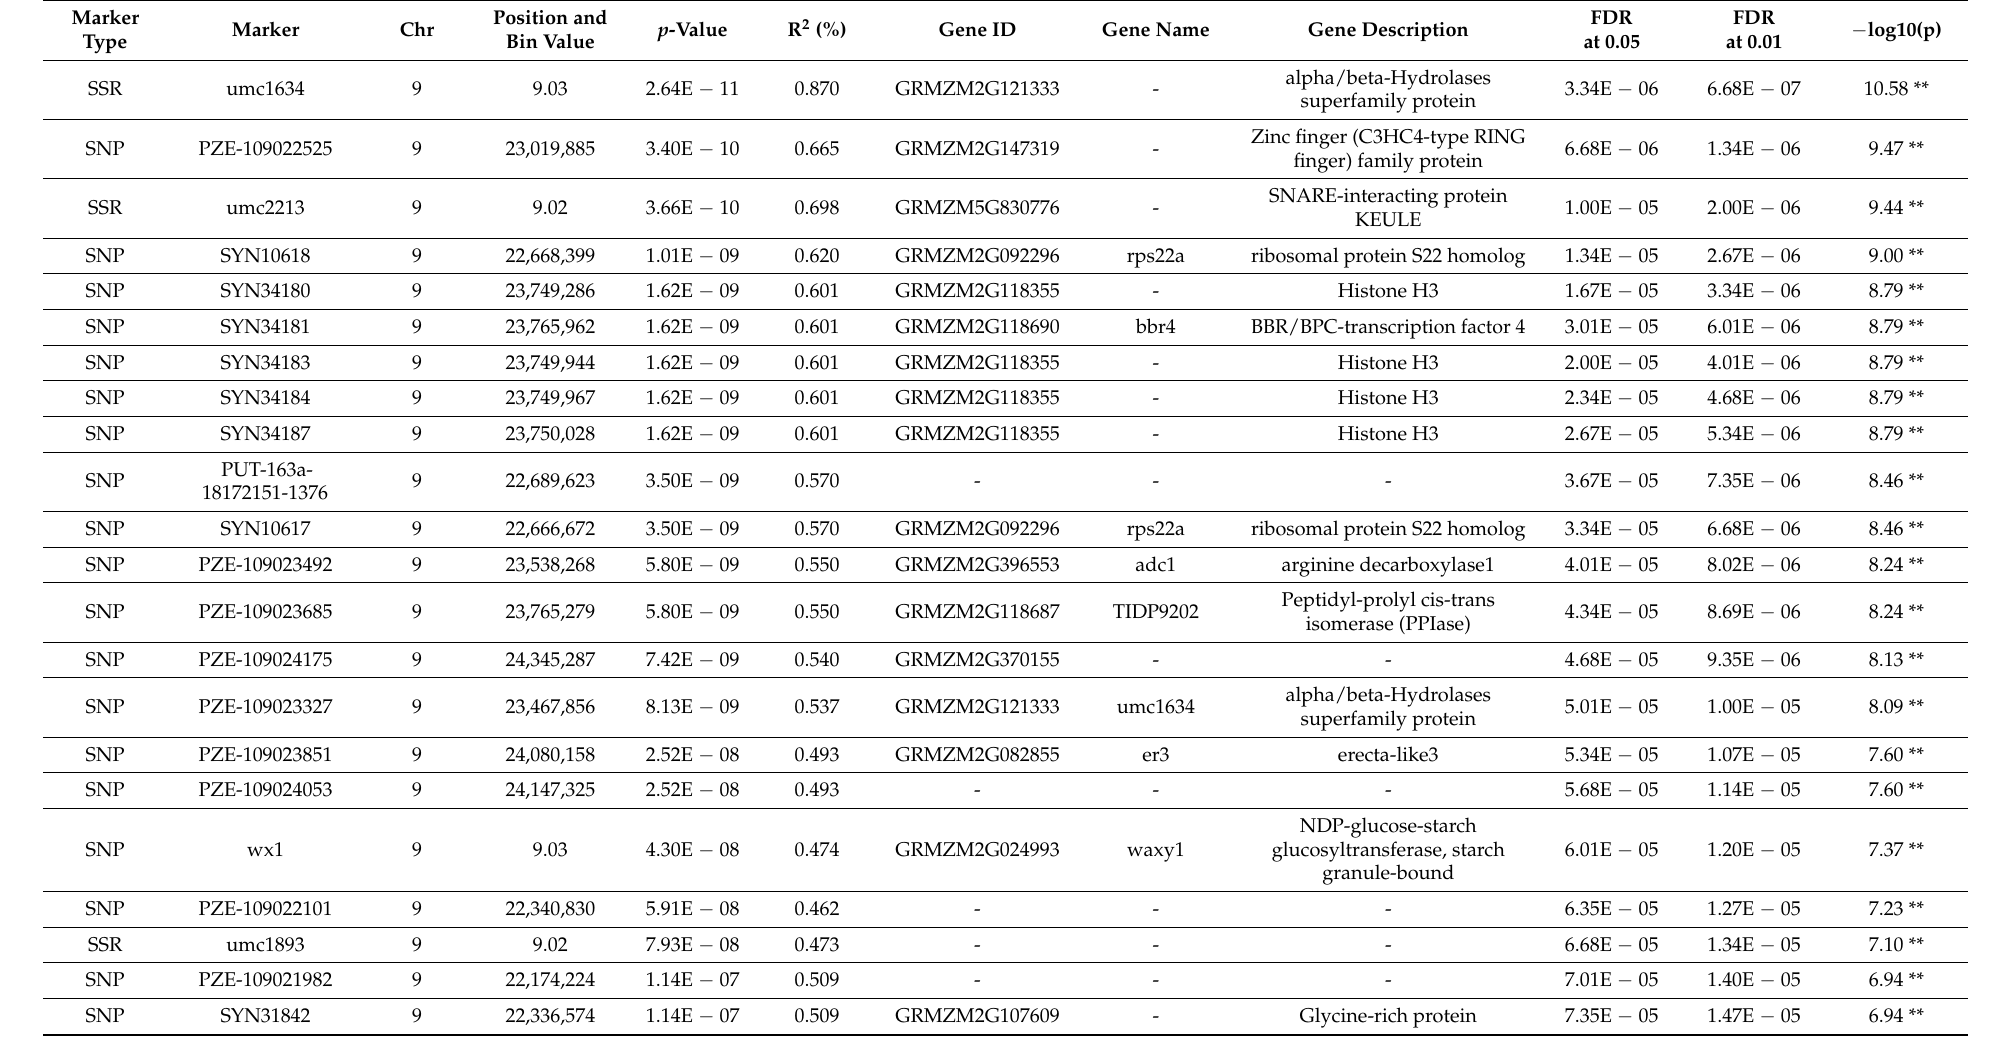
Table 2. Information of marker–trait association for amylose content using Q + K